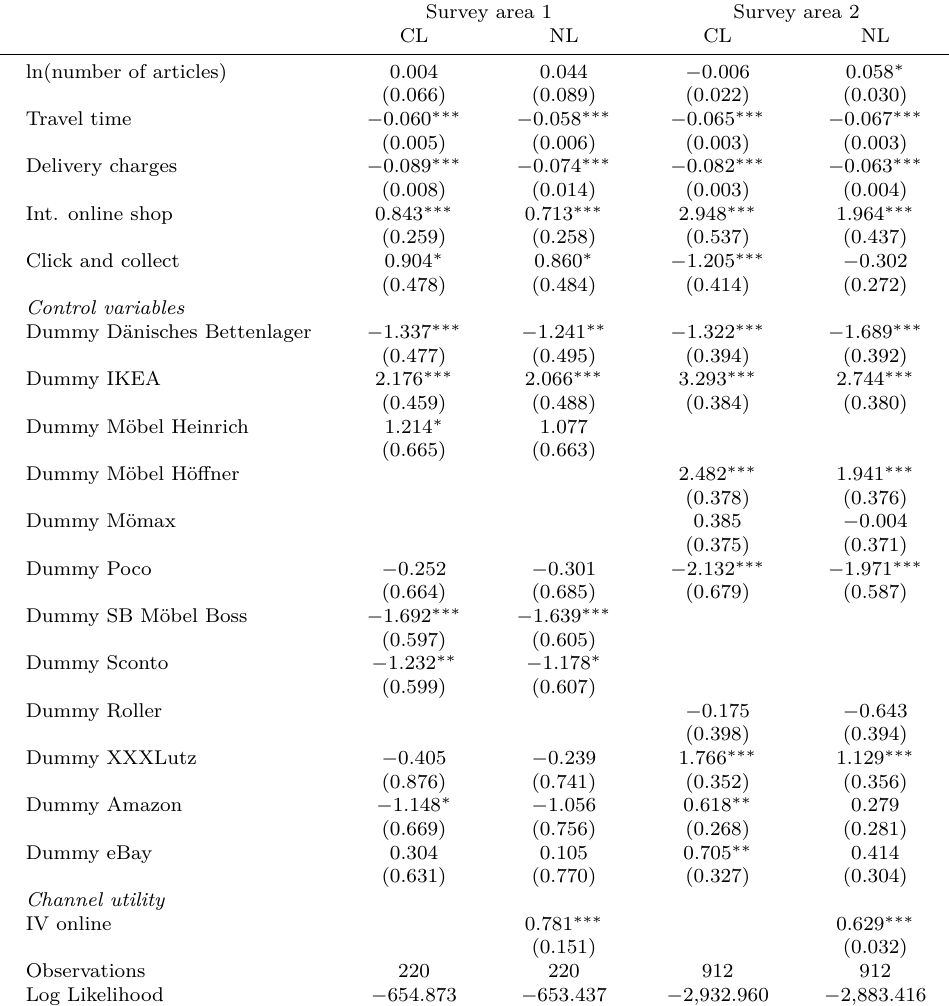
Table 9: Discrete Choice analysis for furniture stores by survey area – Dependent variable: Store choice